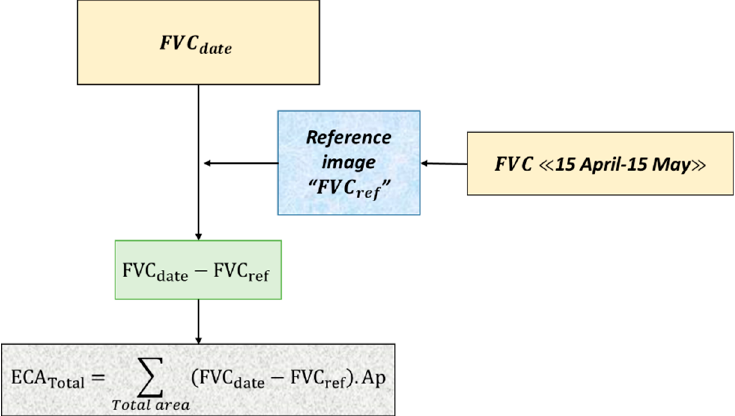
Figure 3. Flowchart for calculating the total area of Eichhornia crassipes (ECAtotal) in the river corridor.